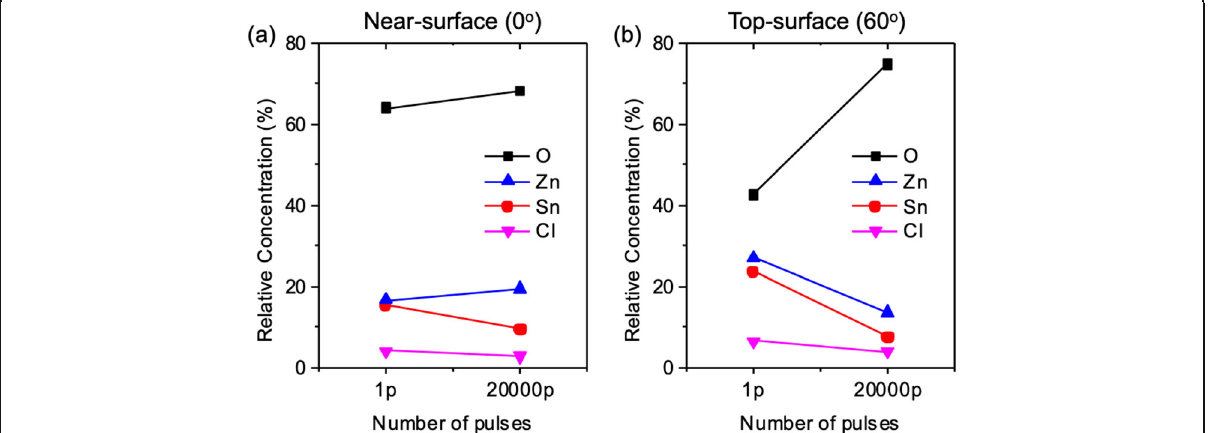
Fig. 2 Relative composition of ZTO films for a the near-surface region (photoelectron emission angle of 0°) and b the top-surface region (60°). As the number of laser pulse increases, oxygen content increases and chlorine content decreases for both measurement